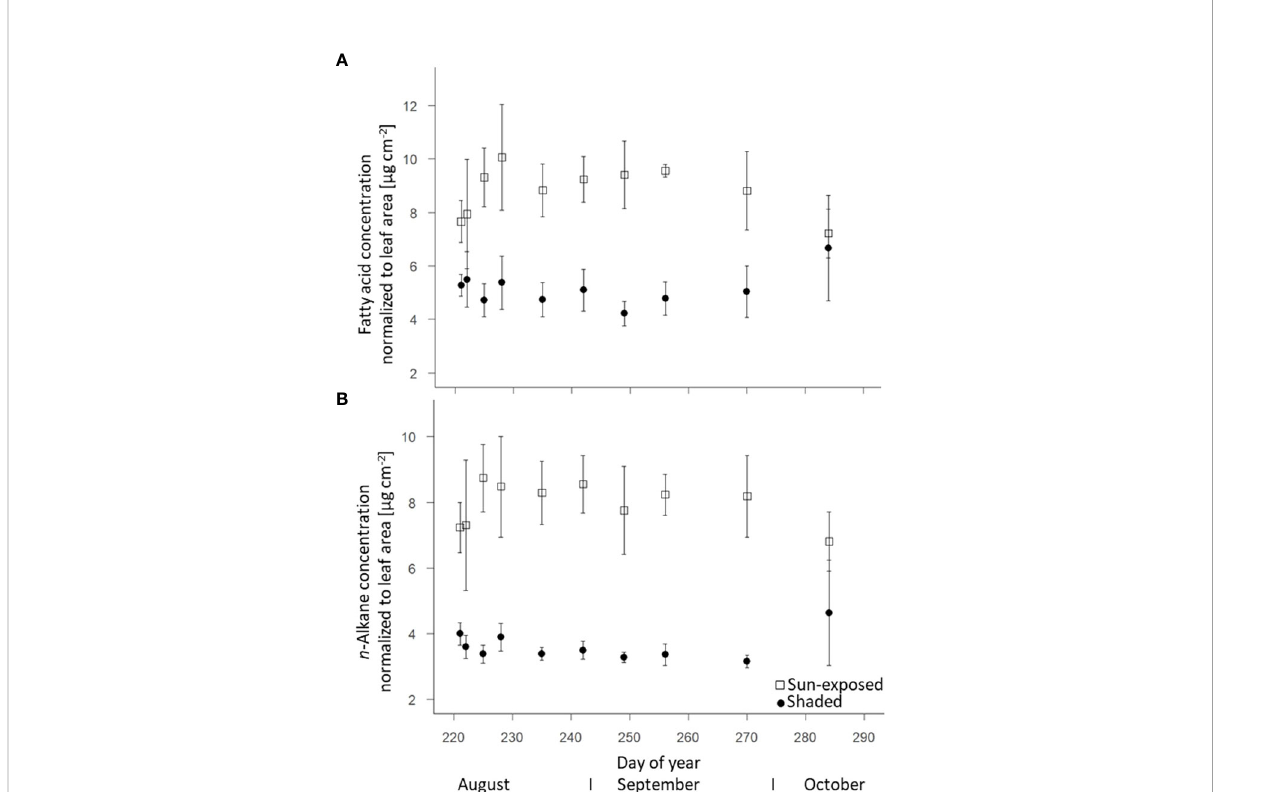
FIGURE 4 Change of fatty acids (intracuticular waxes) (A) and n -alkane (cuticular waxes) (B) concentrations of sun-exposed and shaded leaves during the late growing season ( fi eld replicates n=4, error bar indicate